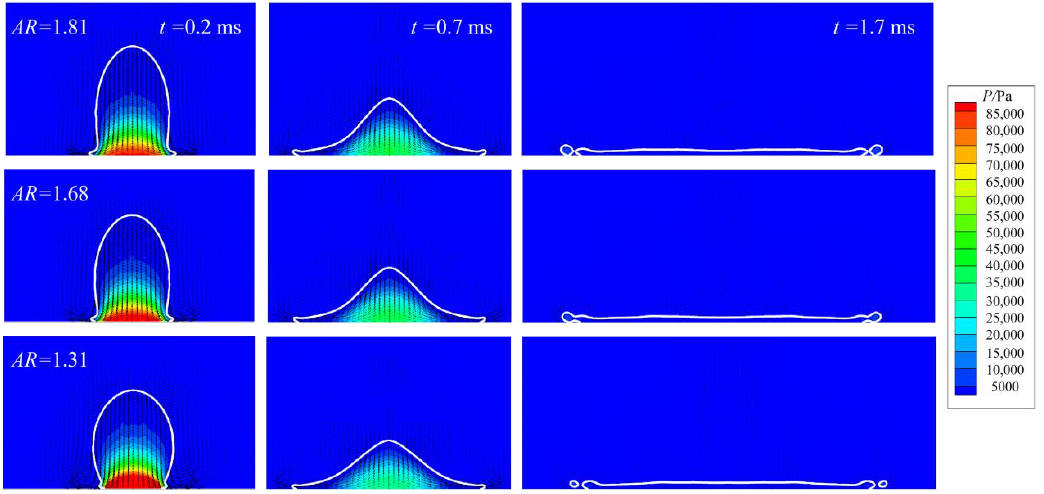
Figure 18. Pressure evolution and streamline distribution during early stages of spreading.